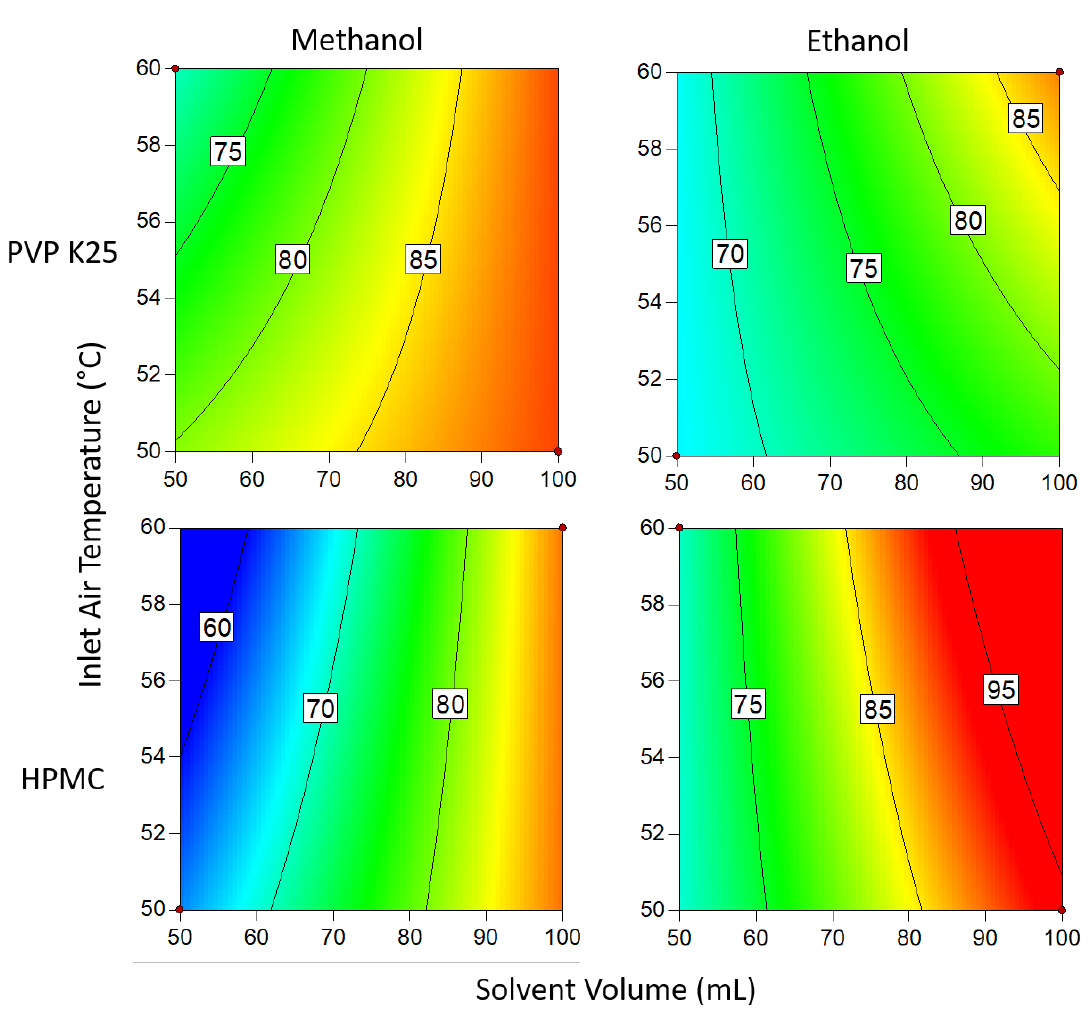
Figure 8. Drug loading efficiency when 3 g of binder is used. Numbers and tie lines correspond to points of equal DLE (%).